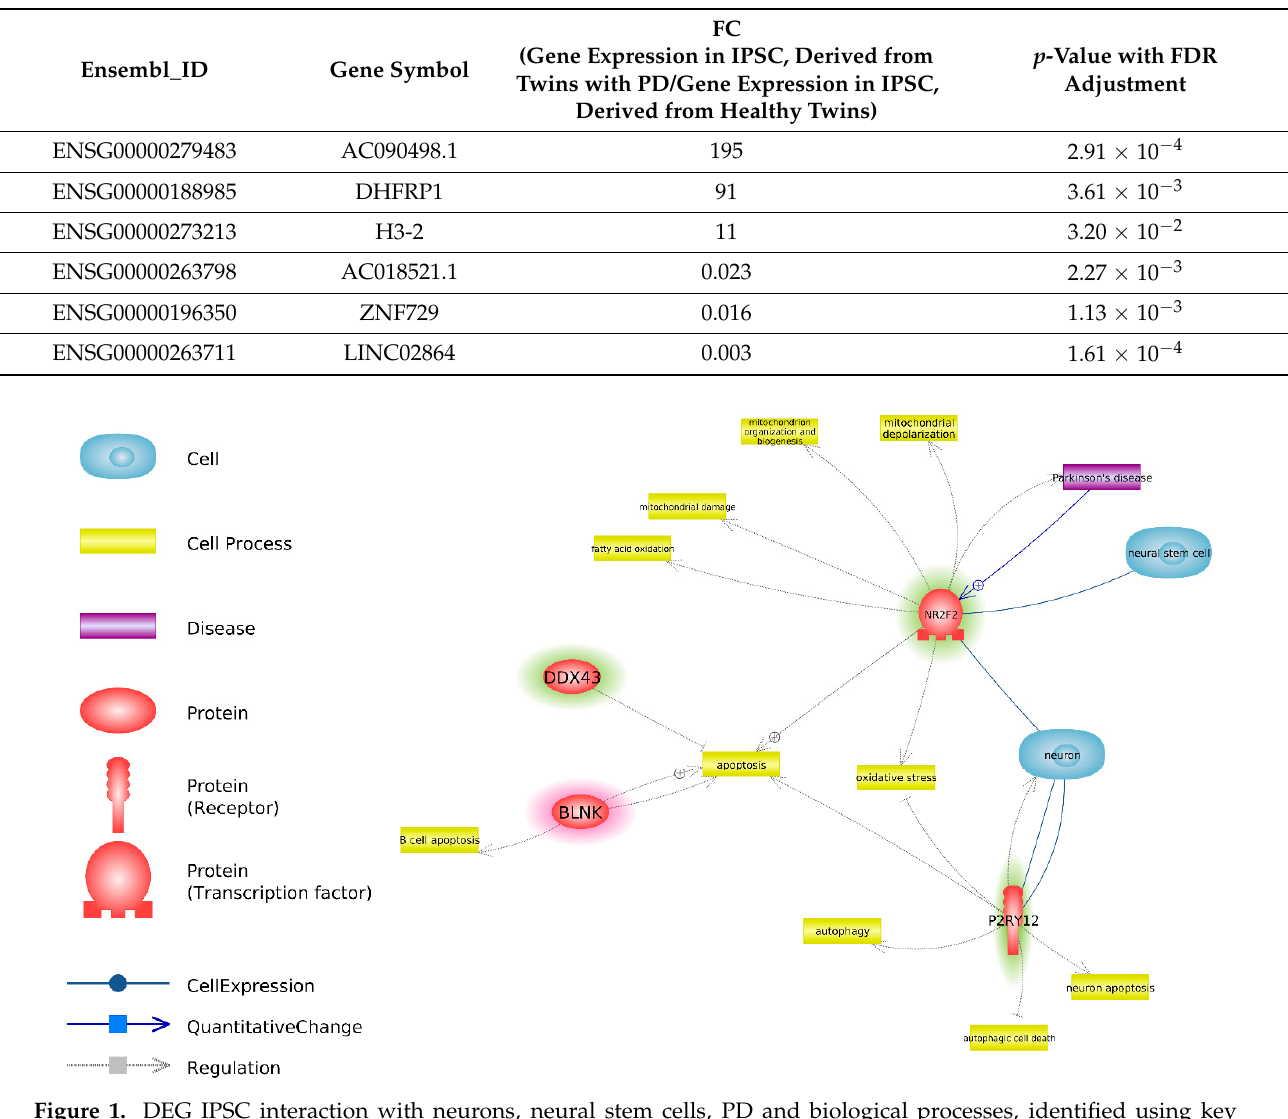
Table 1. Top 3 DEGs up- and down-regulated by fold change in IPSC.